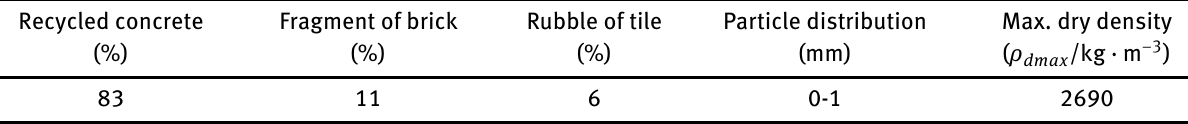
Table 2: Basic characteristic of fine aggregates of construction